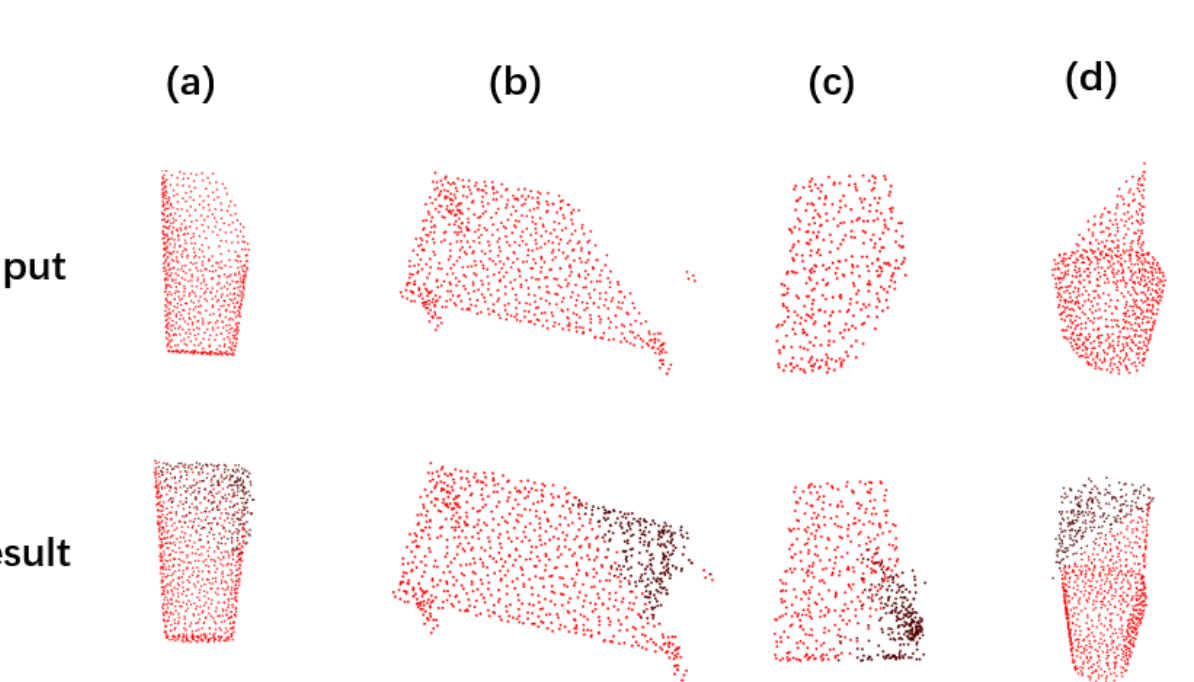
Figure 4. Completion results on ( a ) unseen categories, ( b ) noisy data, ( c ) sparse data, and ( d ) data with rotation of 30–40°. Red points represent the original incomplete point cloud, and black points represent the points generated by the network.